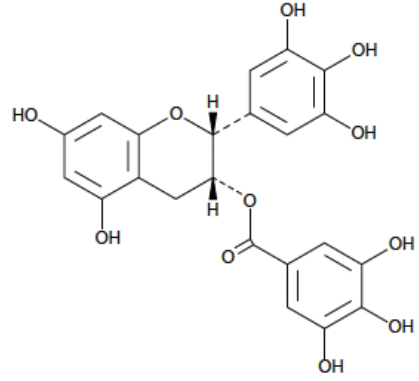
Figure 10. Structure of epigallocathechin gallate.